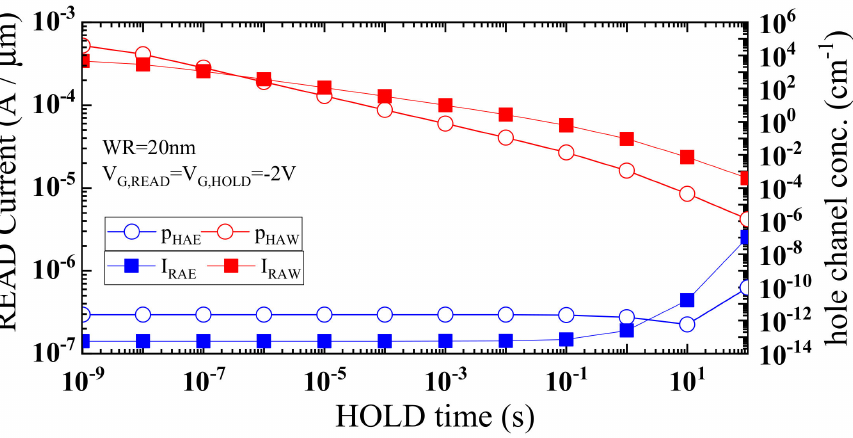
Figure 9. ( left axis ) RAW and RAE currents and ( right axis ) integrated hole concentration in the channel during HAW and HAE as function of the HOLD time. The hole concentration is integrated in the channel and in the body raised region ( − L /2 ≤ x ≤ L /2, y ≥